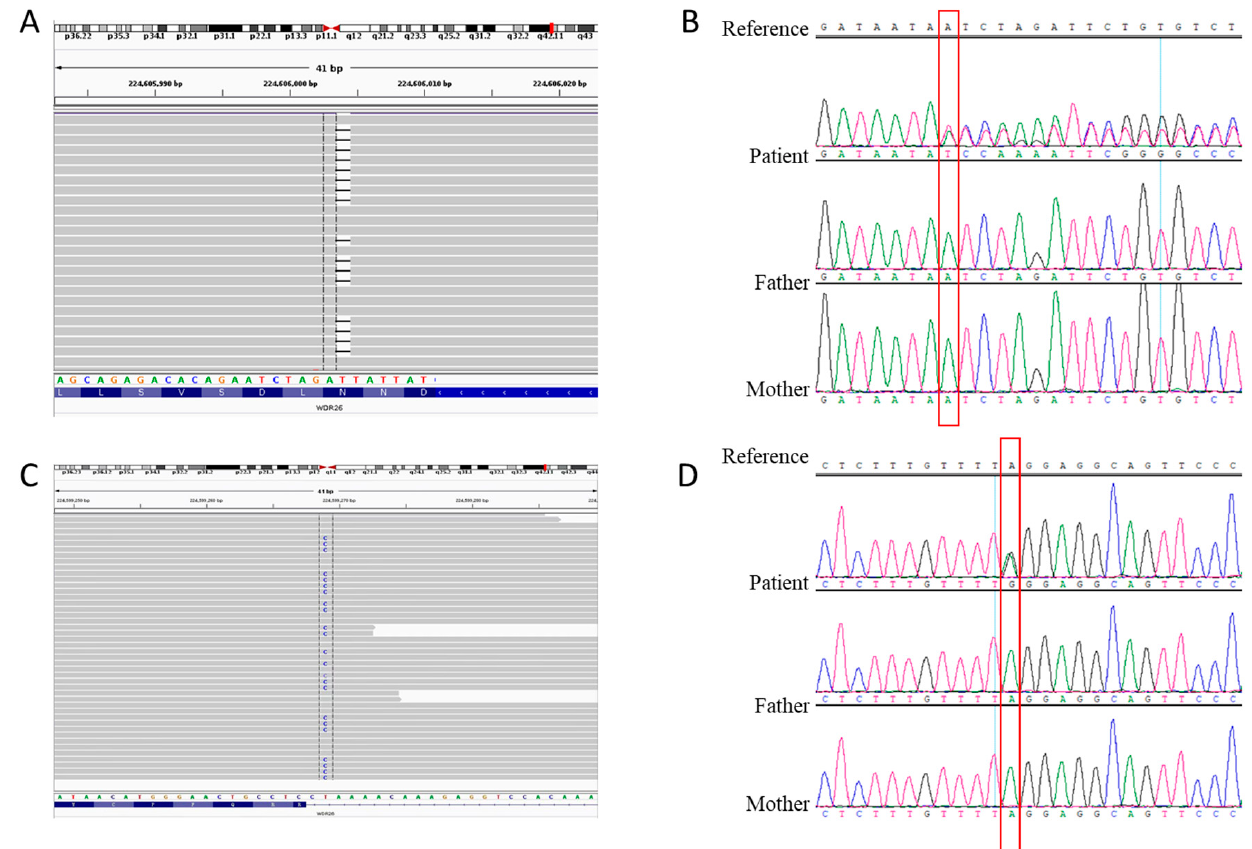
Figure 3. Detection and analysis of the WDR26 variants in our patients. ( A ) The IGV illustration of the c.977delA variant in the WDR26 gene. ( B ) Sanger sequencing results for the c.977delA variant in case 1. The parents were variant negative. ( C ) The IGV illustration of the c.1020-2A>G variant in the WDR26 gene. ( D ) Sanger sequencing results for the c.1020-2A>G variant in case 2. The parents were variant negative.